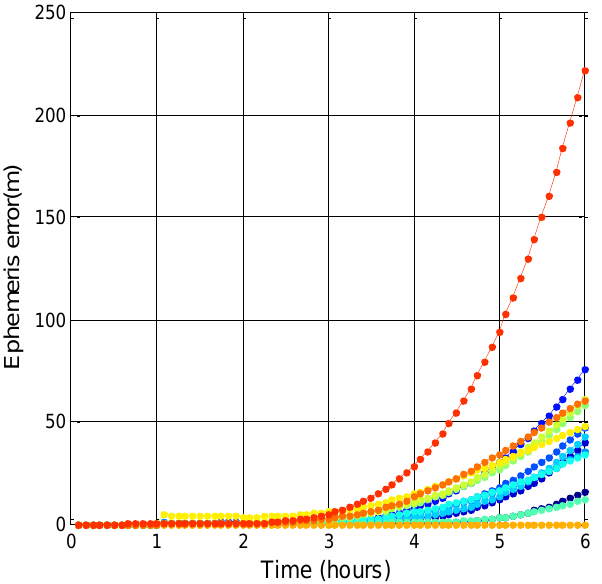
Figure 12. BDS DQA3: The same ephemeris used for 6